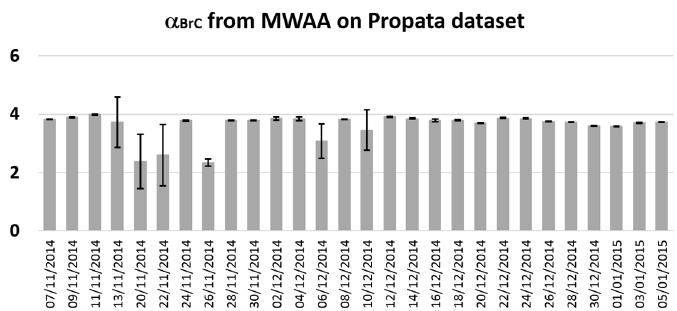
Figure 3. BrC Ångström Absorption exponent ( α BrC) and associated fit uncertainty for the Propata dataset. Date referring to the beginning of the sampling is reported on the x-axis.